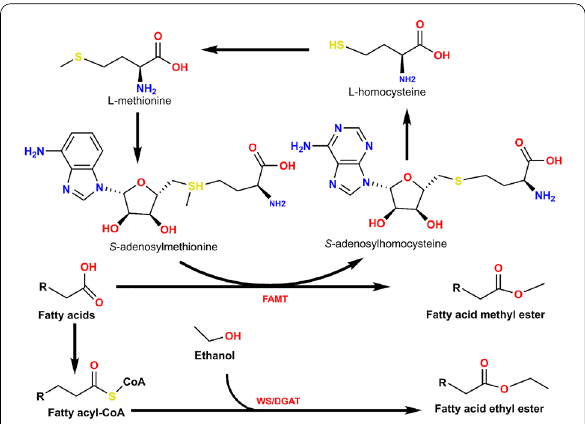
Fig. 6 Schematic diagram of the production of FAME and FAEE by an engineering